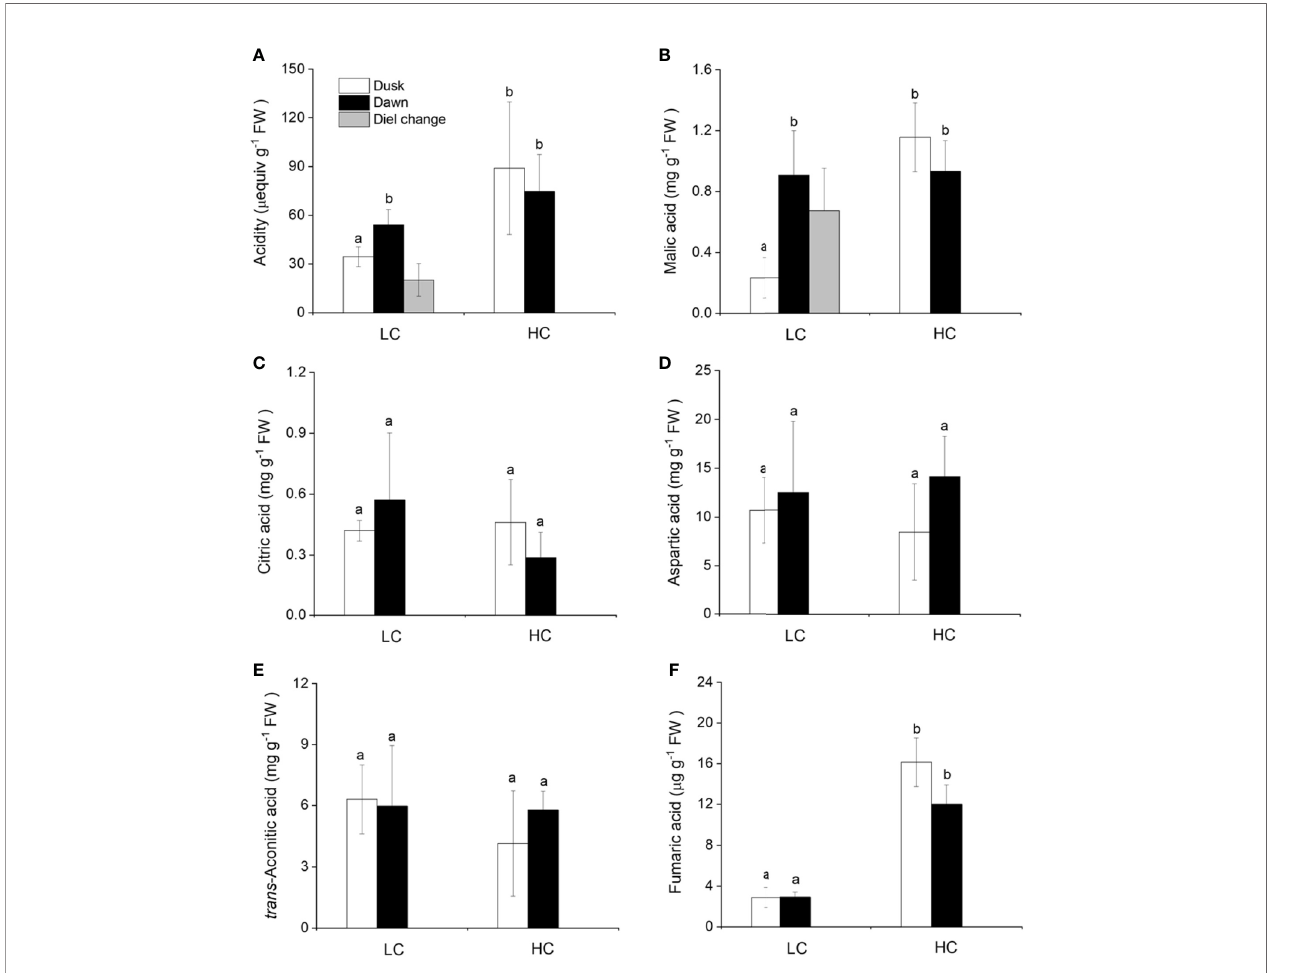
FIGURE 3 | In fl uence of CO 2 concentrations on acidity and concentrations of organic acids from O. cordata fl oating leaves collected at dusk (21:00 h, before the lights turn off) and dawn (07:00 h, before the lights turn on). (A) Acidity. (B) Malic acid. (C) Citric acid. (D) Aspartic acid. (E) trans -Aconitic acid. (F) Fumaric acid. LC means low CO 2 ; HC means high CO 2 . The mean values (n=3) with their s.d. are shown. Different letters indicate signi fi cant differences ( p <0.05, post hoc Duncan ’ s test) among